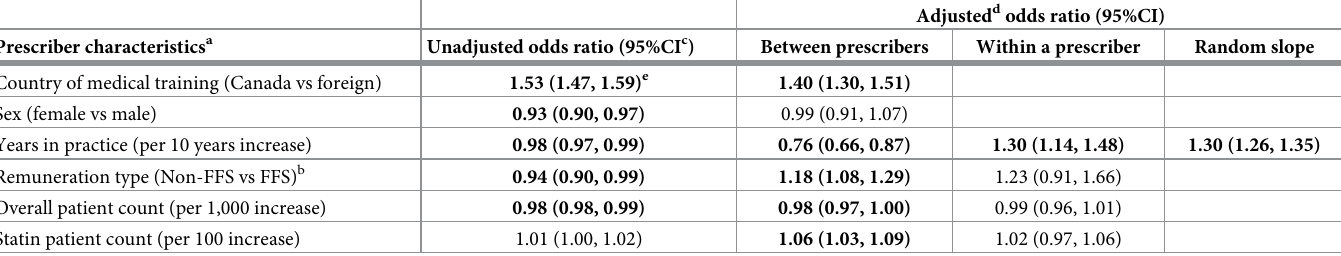
Table 2. Odds ratios (95% confidence interval) for the association of prescriber-related characteristics with optimal statin adherence (proportion of days covered by statin medications > =